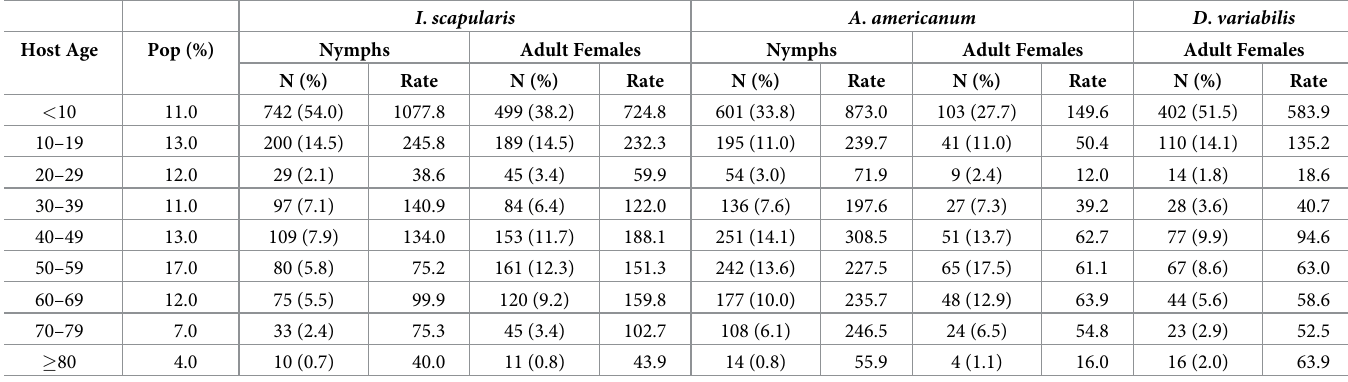
Table 2. Percentage and rate of tick submissions by human host age classes. Monmouth County population data obtained from U.S. Census Bureau [35]. I . scapularis A . americanum D .